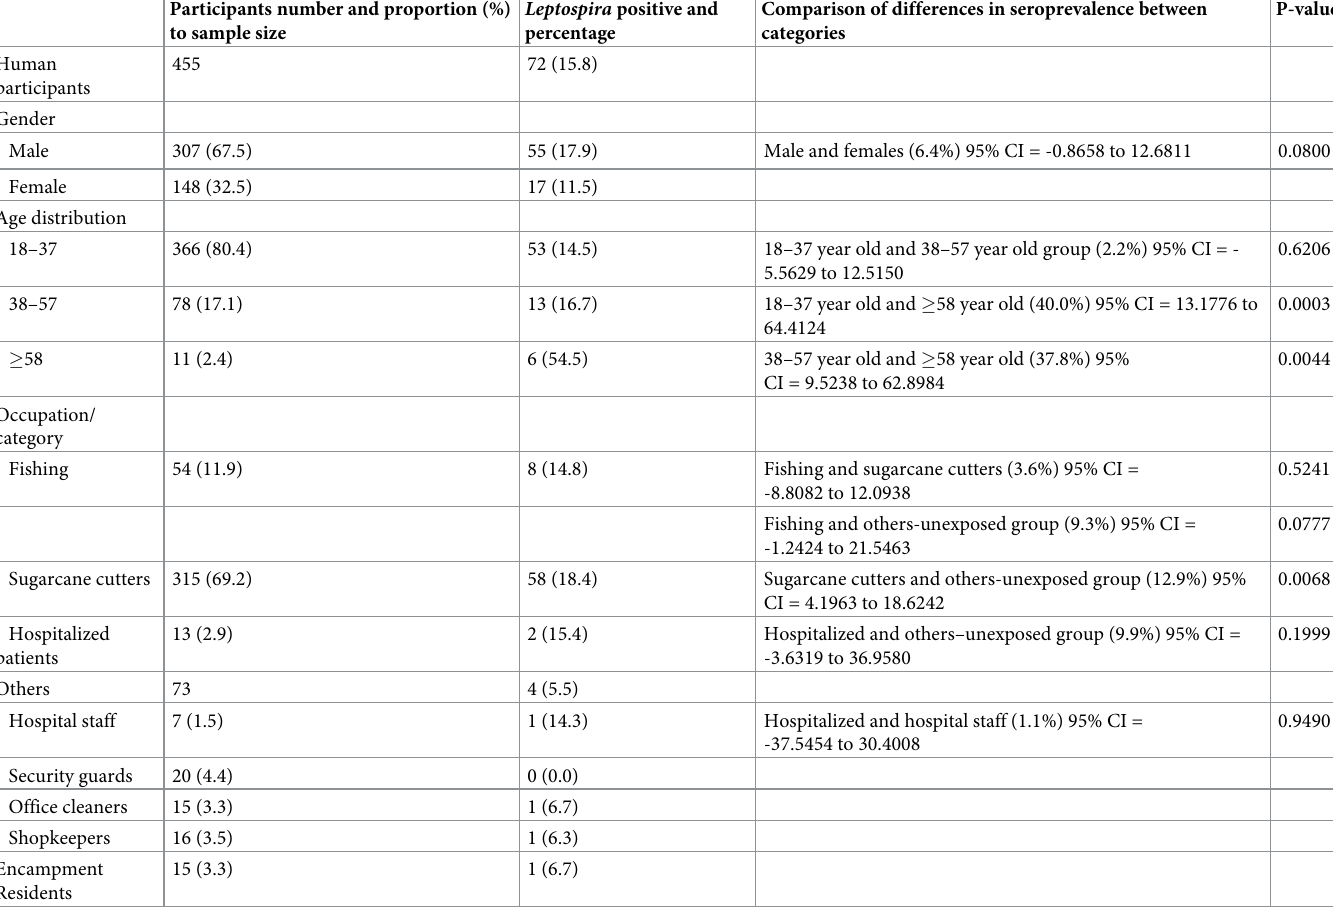
Table 1. Demographic information of human participants (n = 455). Participants number and proportion (%) to sample